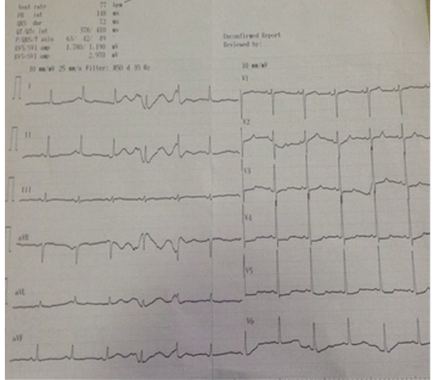
Figure 2: Electrocardiogram revealed findings consistent with myocardial infarction.